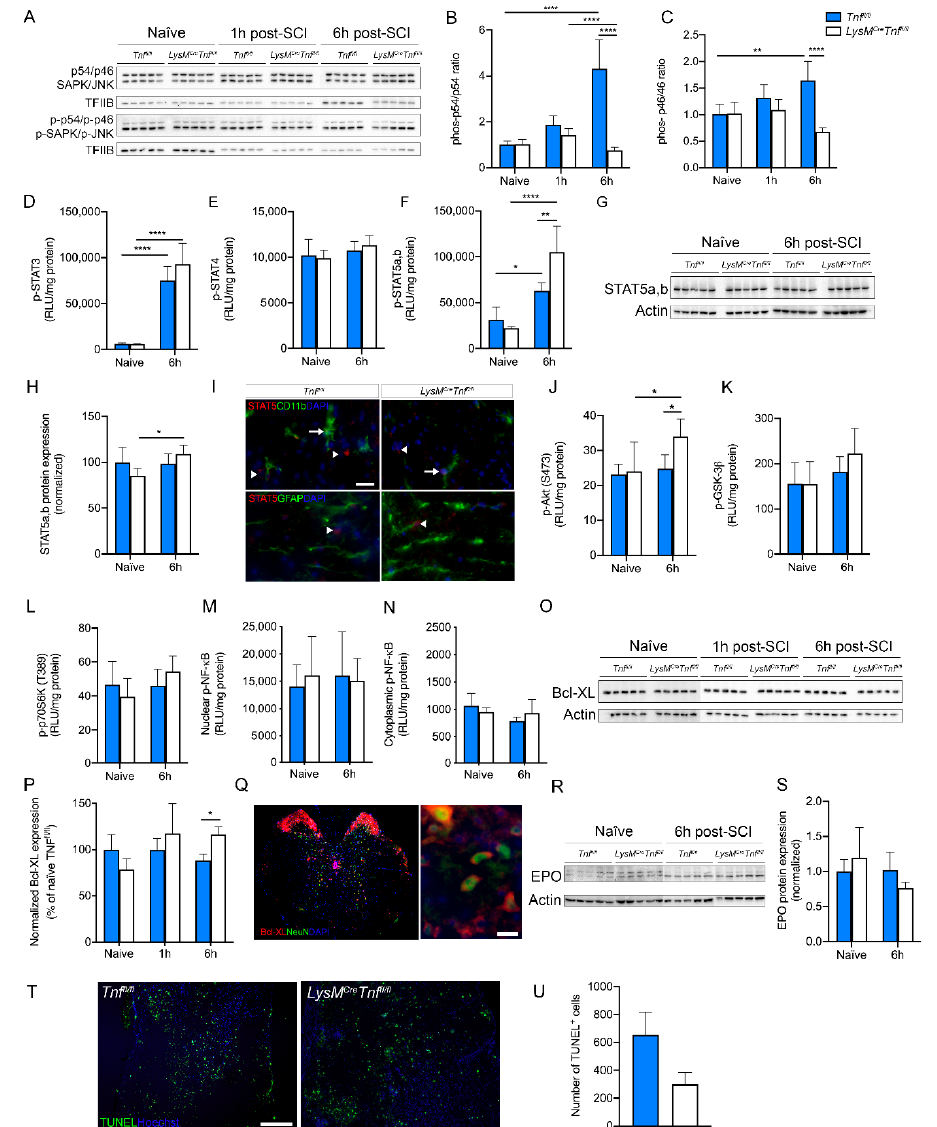
Figure 5. Changes in downstream signaling pathways after SCI in mice with conditional ablation of myeloid TNF. ( A – C ) Quantification of SAPK / JNK and phorphorylated (p)-SAPK / p-JNK protein expression in spinal cord tissue of naïve Tnf fl / fl and LysM Cre Tnf fl / fl mice and 1 and 6 h after SCI. The SAPK / p-SAPK ratio (two-way ANOVA SAPK / p-SAPK, SCI: p < 0.0001, F 2,24 = 18.10; Genotype: p < 0.0001, F 1,24 = 40.75; Interaction: p < 0.0001, F 2,24 = 29.25) and the JNK / p-JNK ratio (two-way ANOVA JNK / p-JNK, SCI: ns; Genotype: p < 0.0001, F 1,24 = 22.27; Interaction: p < 0.001, F 2,24 = 12.49) were decreased in LysM Cre Tnf fl / fl compared to Tnf fl / fl mice 6 h after SCI. Data are normalized to transcription factor II B (TFIIB) protein expression, n = 5 / group. ( D – F ) Electrochemiluminescence analysis of p-STAT3 (two-way ANOVA, SCI: p < 0.0001, F 1,16 = 159.1; Genotype: ns; Interaction: ns) ( D ), p-STAT4 (two-way ANOVA: ns) ( E ), and p-STAT5a,b (two-way ANOVA, SCI: p < 0.0001, F 1,16 = 60.71; Genotype: p < 0.05, F 1,16 = 5.03; Interaction: p < 0.01, F 1,16 = 12.31) (F) protein expression in spinal cord tissue of naïve Tnf fl / fl and LysM Cre Tnf fl / fl mice and 6 h after SCI, n = 5 / group. ( G , H ) Quantification of STAT5a,b protein expression in spinal cord tissue of naïve Tnf fl / fl and LysM Cre Tnf fl / fl mice and 6 h after SCI (two-way ANOVA, SCI: p < 0.05, F 1,16 = 4.81; Genotype: ns; Interaction: p < 0.05, F 1,16 = 5.97). Data are